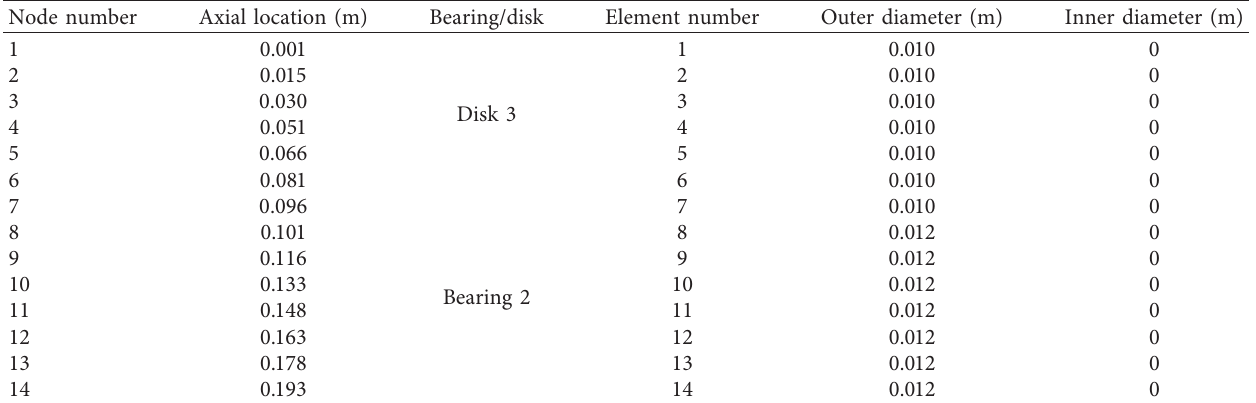
Figure 6: The mesh diagram of the bearing-rotor system. Table 4: Dimension and elements information of the bearing-rotor